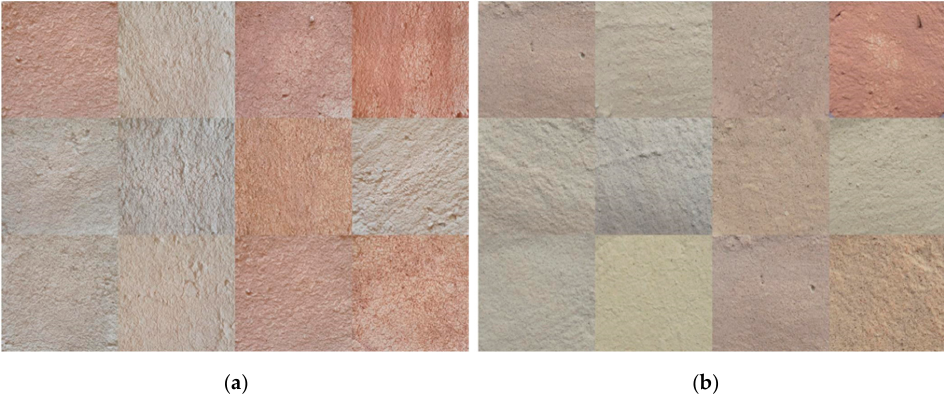
Figure 15. Lime colours on lime plaster: ( a ) limewater (1:6); ( b ) limemilk (1:3). Table 11. Limecolours in CIEL*a*b colour scale.